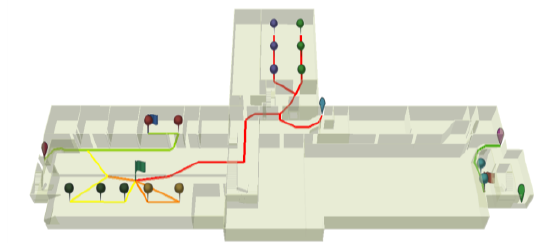
Figure 17. Generated Staff Evacuation Basement Routes